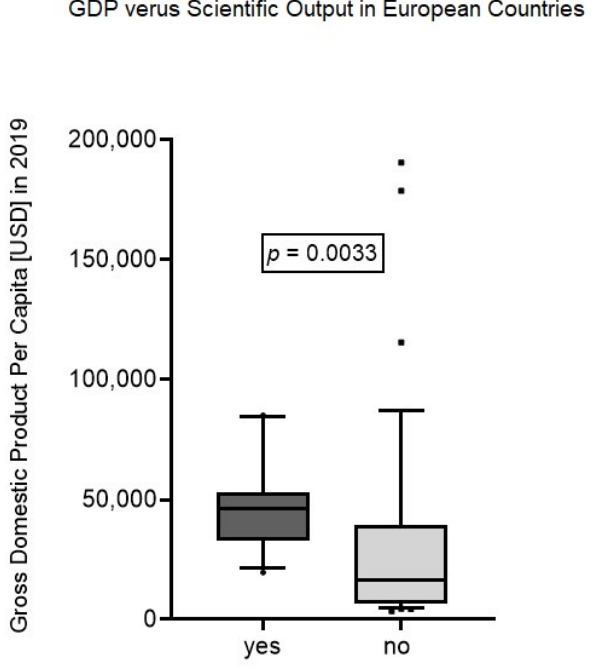
Figure 5. GDP versus scientific output in European countries.